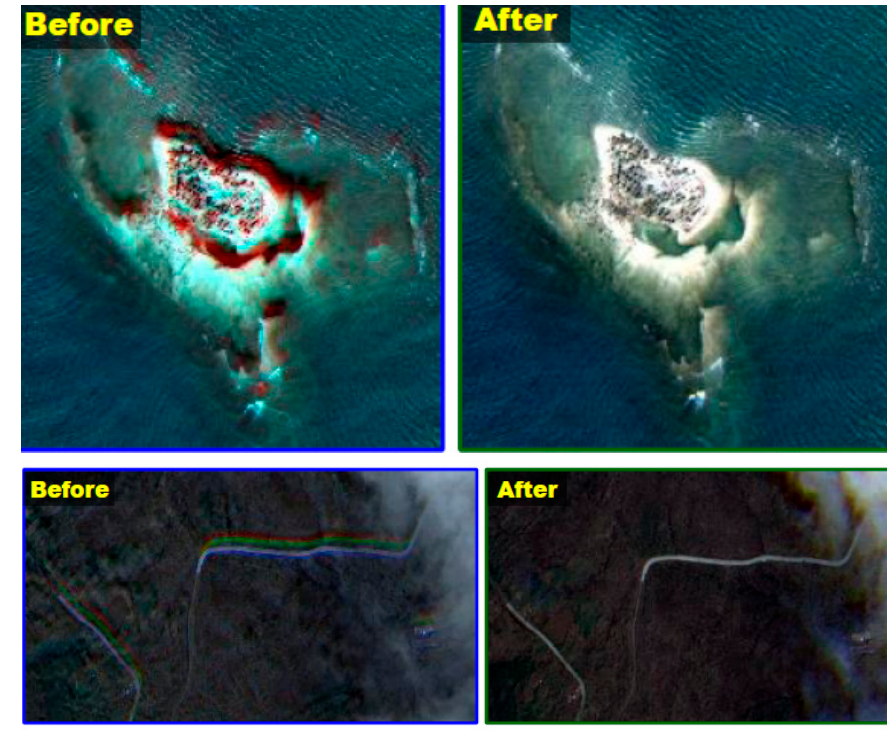
Figure 11. Examples of the band-to-band registration results.